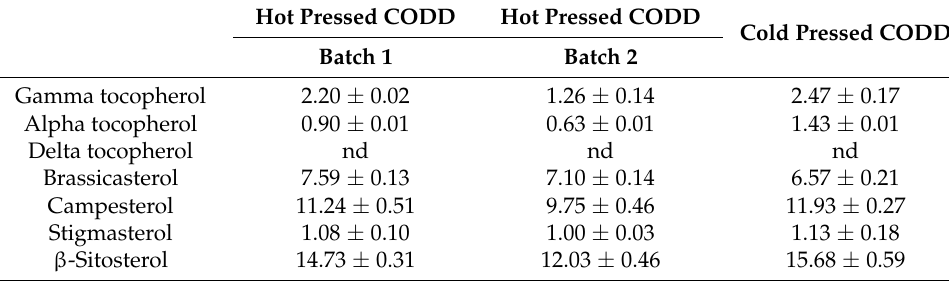
Table 5. Phytosterols and tocopherols content (%) in